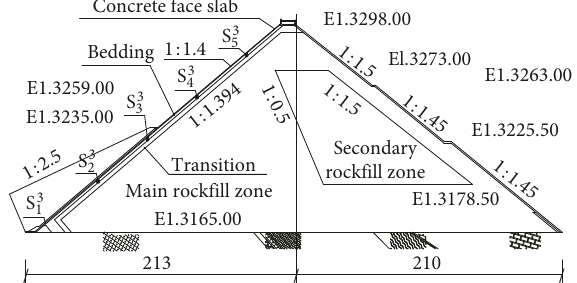
Figure 4: Typical dam section and concrete-face rebar meter